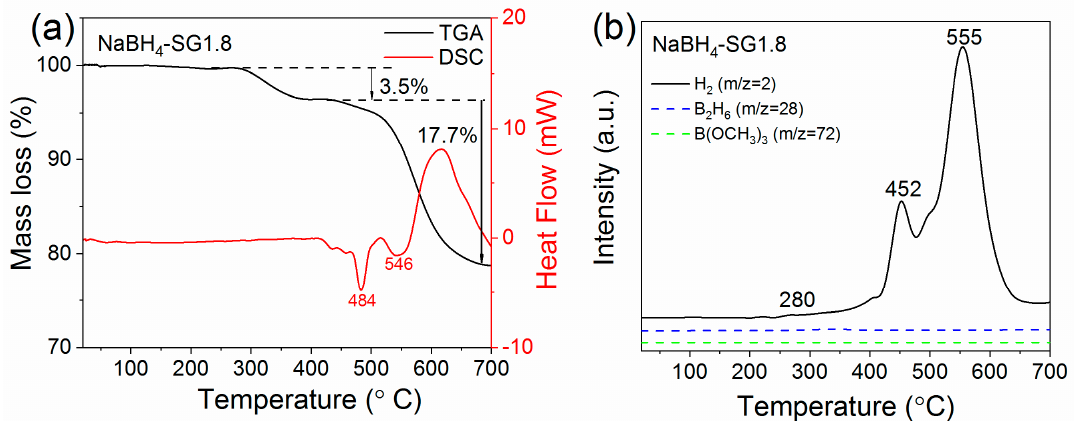
Figure 7. ( a ) TGA / DSC under Ar of NaBH 4 -SG1.8; ( b ) H 2 desorption from NaBH 4 -SG1.8 recorded by mass spectrometry and selected mass corresponding to the release of B 2 H 6 and B(OCH 3 ) 3 .